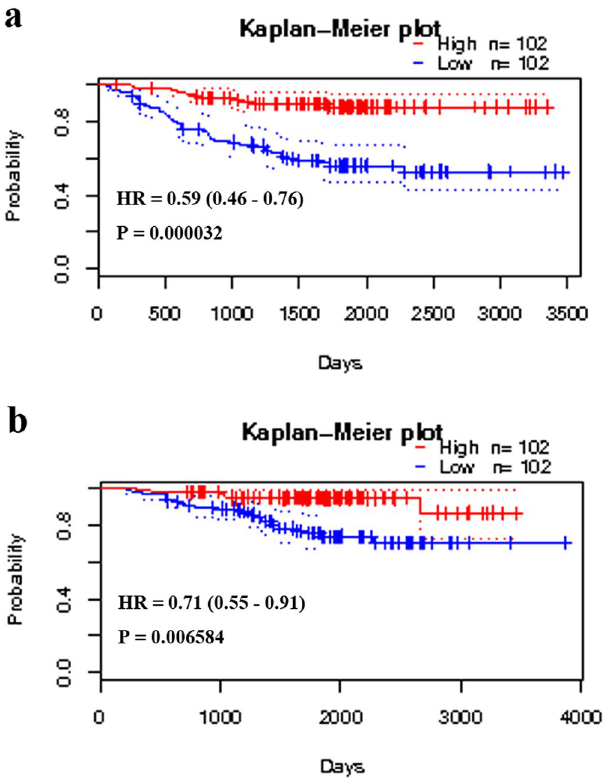
Figure 7. Kaplan–Meier survival curves generated from PrognoScan for TCF21 mRNA expression in patients with lung adenocarcinoma. Relapse-free survival curves ( a ) or overall survival curves ( b ) for lung adenocarcinoma patients in the GEO dataset GSE31210. HR = hazard